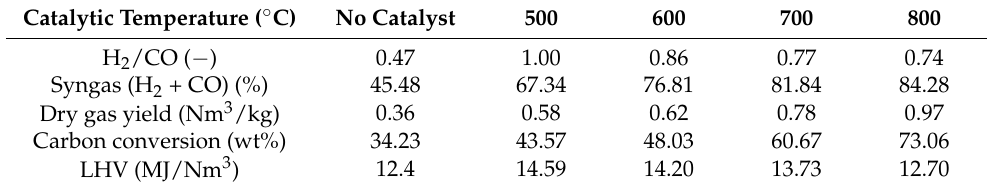
Table 2. Effect of catalytic temperature on properties of gas products.